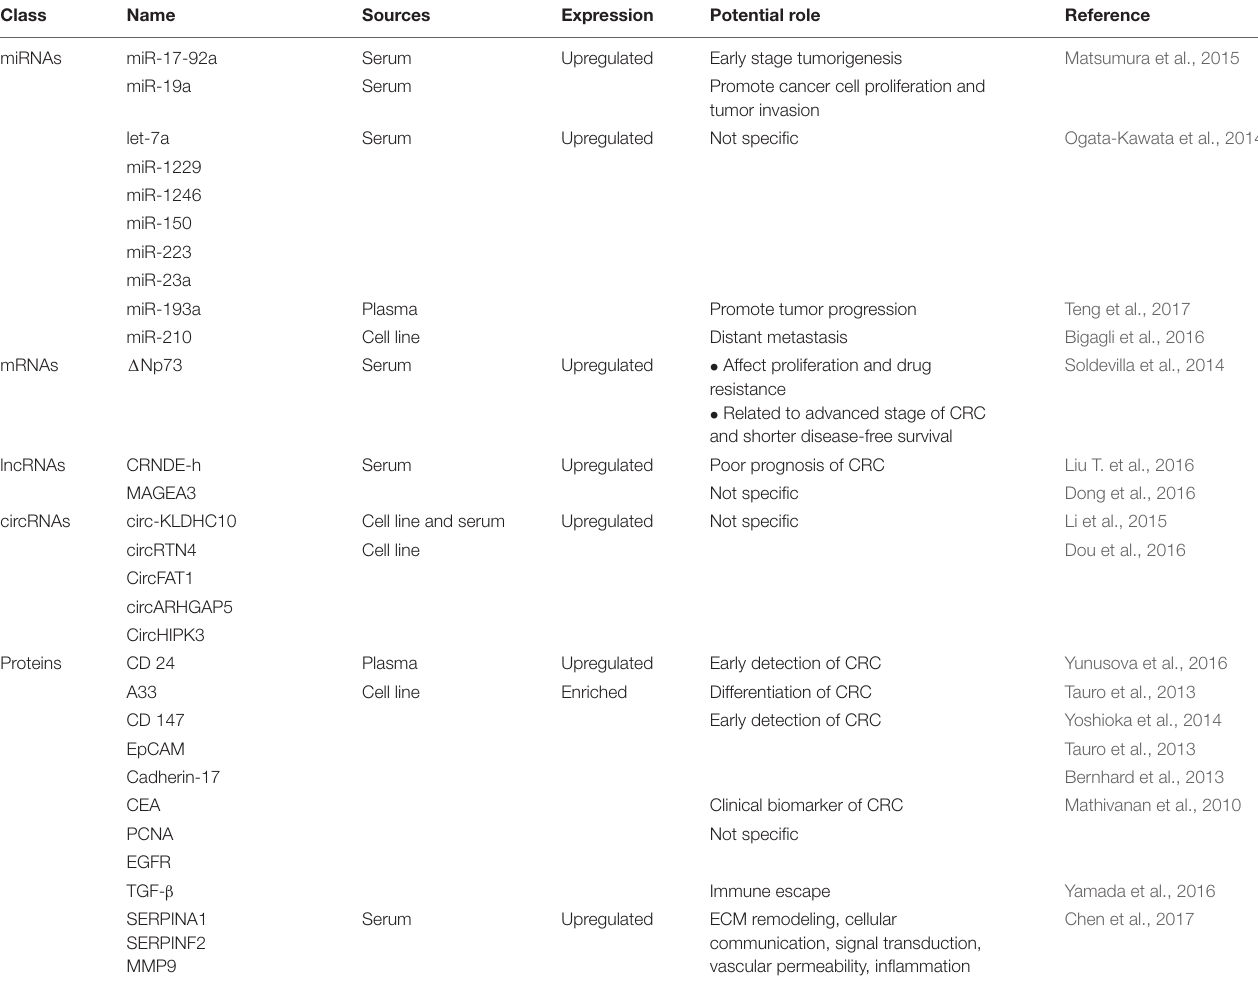
TABLE 1 | Summary of studies that have investigated differentially expressed exosomal nucleic acids in